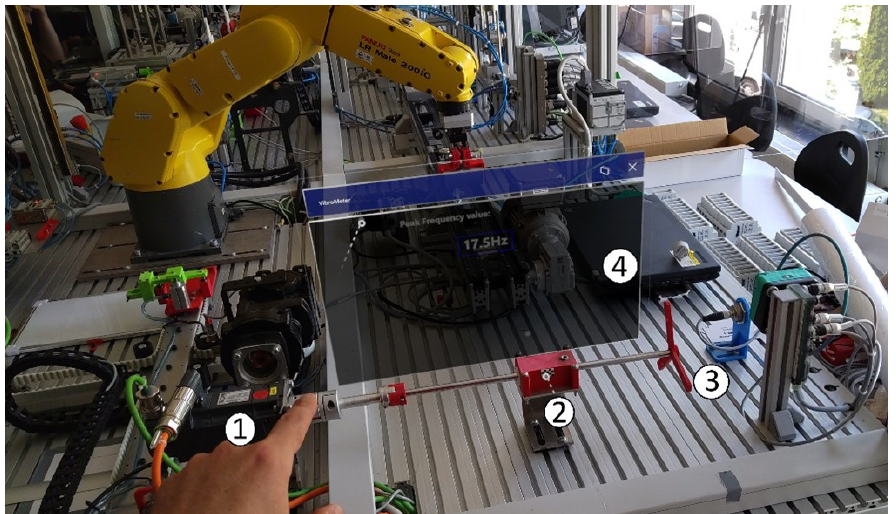
Figure 4. Marker’s placement on wind turbine model and view from HoloLens. 1—servomechanism; 2—checkerboard marker; 3—propeller; and 4—measured peak frequency displayed by the